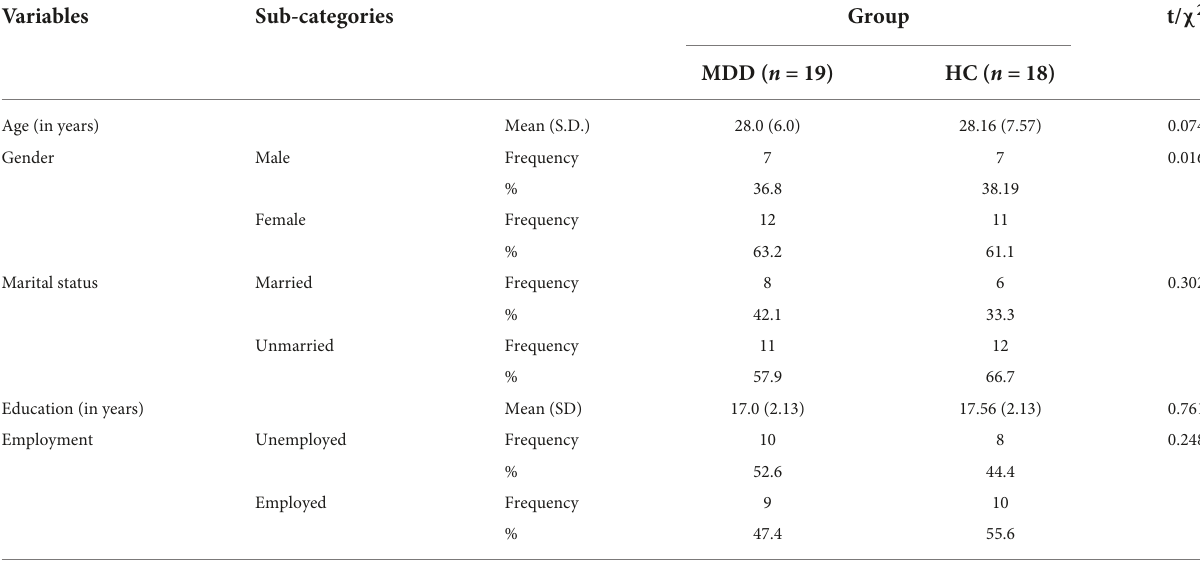
TABLE 2 Clinical status of the MDD group ( n =